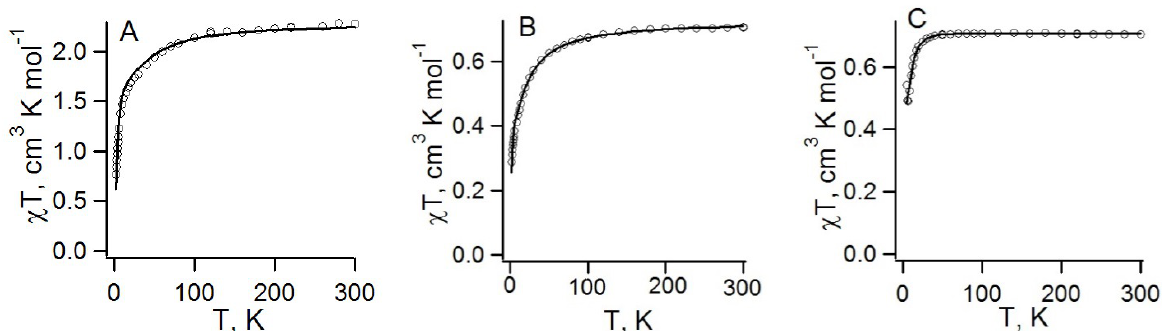
Figure 21. Experimental temperature dependences (circles) of the products χ T in the temperature range 2 − 300 K for salts 78 ([CrCp* and 77 ([CrTol ][ 75 ], C ). The fitting parameters are as follows: 78 , J 2 J = − 7.96 cm − 1 (oversimplified model consisting of two types of anion…cation 2